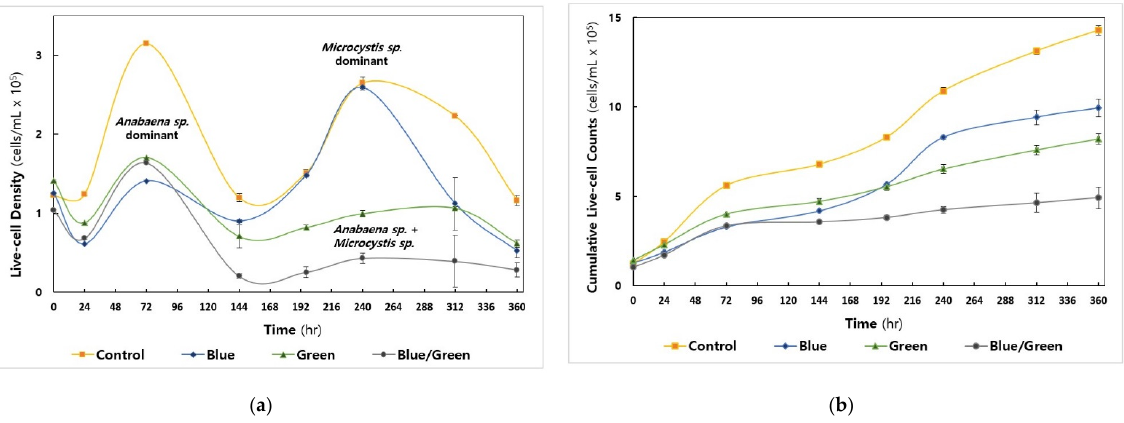
Figure 2. Cyanobacterial cell growth under the experimental conditions (Control: No intervention, Blue: Blue film, Green: Green film, Blue/Green: Blue and Green films). All experiments were carried out in triplicate. ( a ) Measurement of cyanobacterial live-cell density by flow cytometry ( b ) The cumulative number of cells counted.